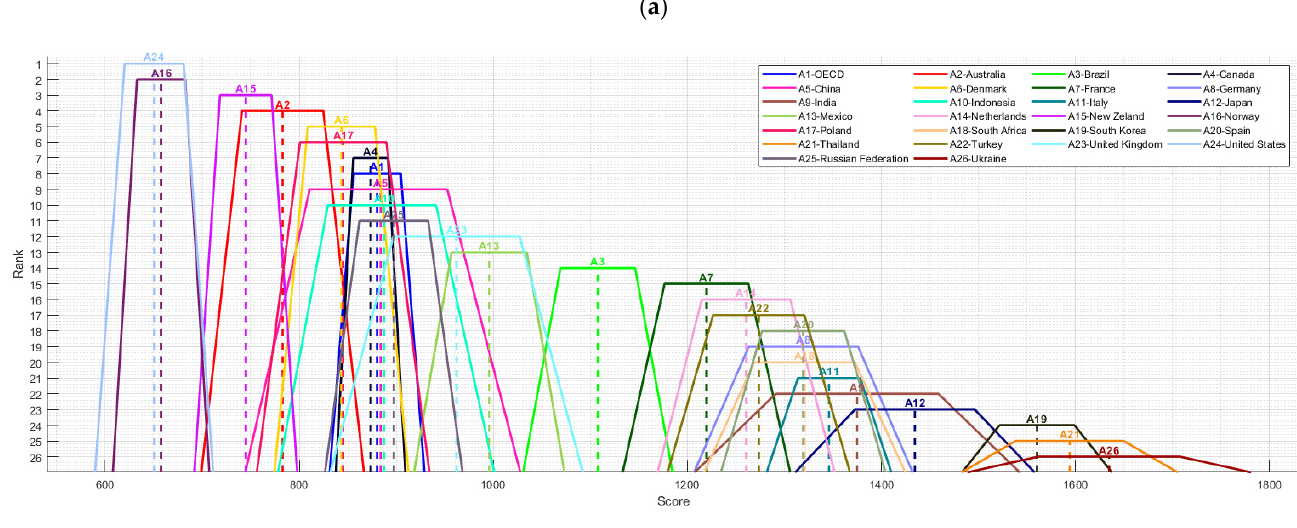
Figure 3. IESRI ranking obtained on the basis of the forecasted values of the categories, using TFNs constructed using: ( a ) standard deviation based fuzzification, ( b ) half distance based fuzzification. Table 5. IESRI rankings obtained using forecasted values of metrics and categories, as well as various fuzzification meth- ods.